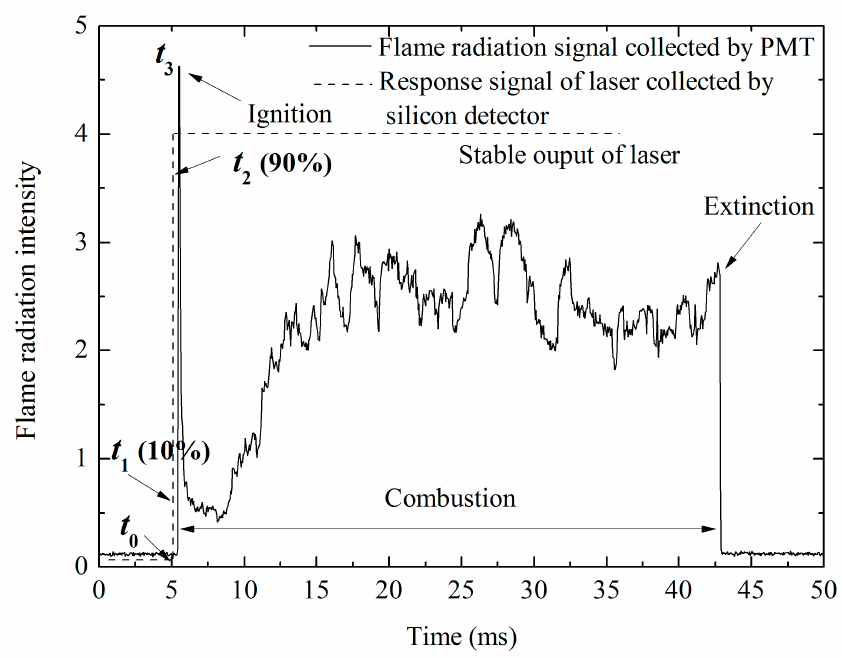
Figure 7. The curves are used to measure the ignition delay time of individual micron-sized graphite particles. The solid line shows the history of flame radiation intensity of the individual micron-sized graphite particles during combustion, which was acquired by the PMT (photomultiplier tube). The dashed line presents the history of the laser beam from turning it on to its stable output, which was acquired by a silicon detector.